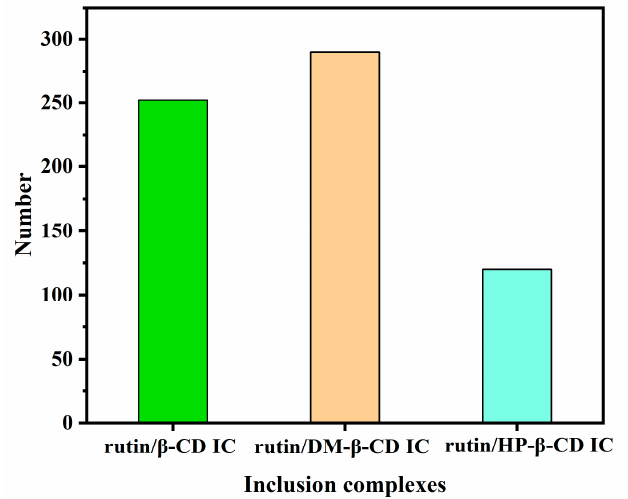
Figure 8. Number of images of an optimal configuration of a triple inclusion complex. The corresponding most-stable conformations of the obtained inclusion complexes are shown in Figure 9.